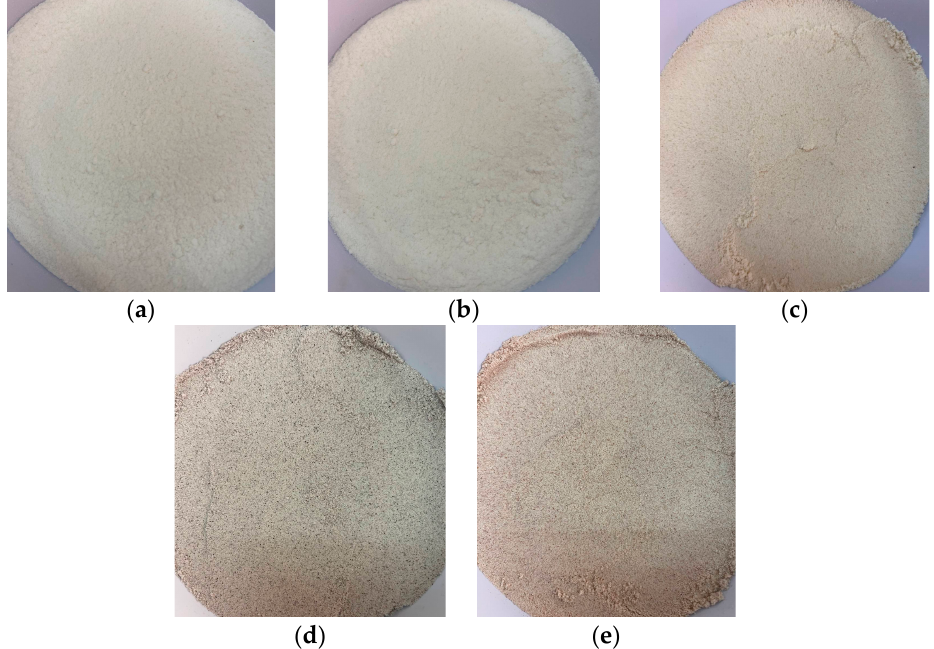
Figure 1. The colour diversity of ( a ) TQR (reference sample) and Bario rice flour, ( b ) Bario Adan Halus , ( c ) Bario Tuan , ( d ) Bario Celum , and ( e ) Bario Merah Sederhana. ( c ) Bario Tuan , ( d ) Bario Celum , and ( e ) Bario Merah Sederhana